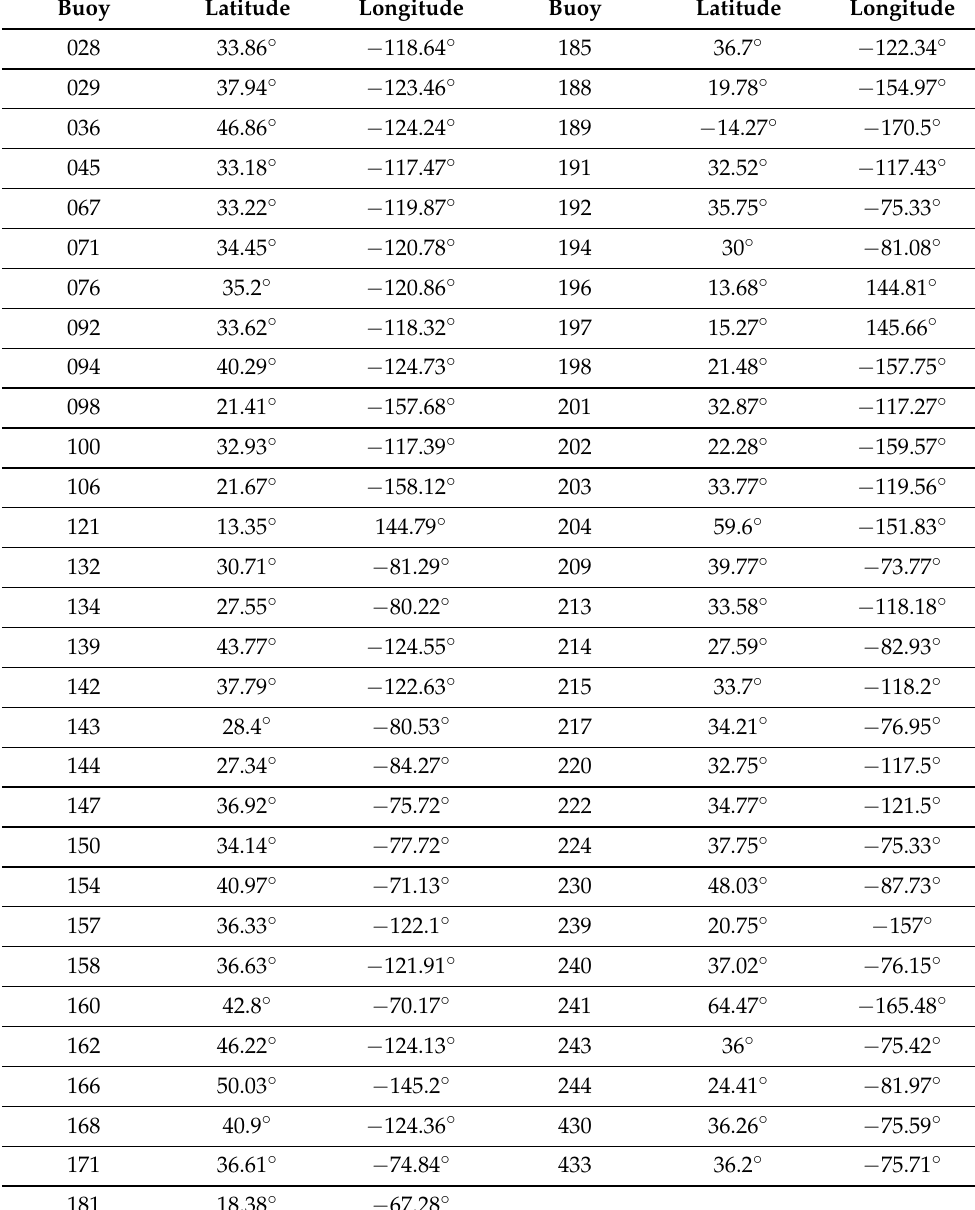
Table 1. Buoys identification number, with associated longitud and latitude coordinates, whose surface elevation measurements constitute the datasets analyzed in this